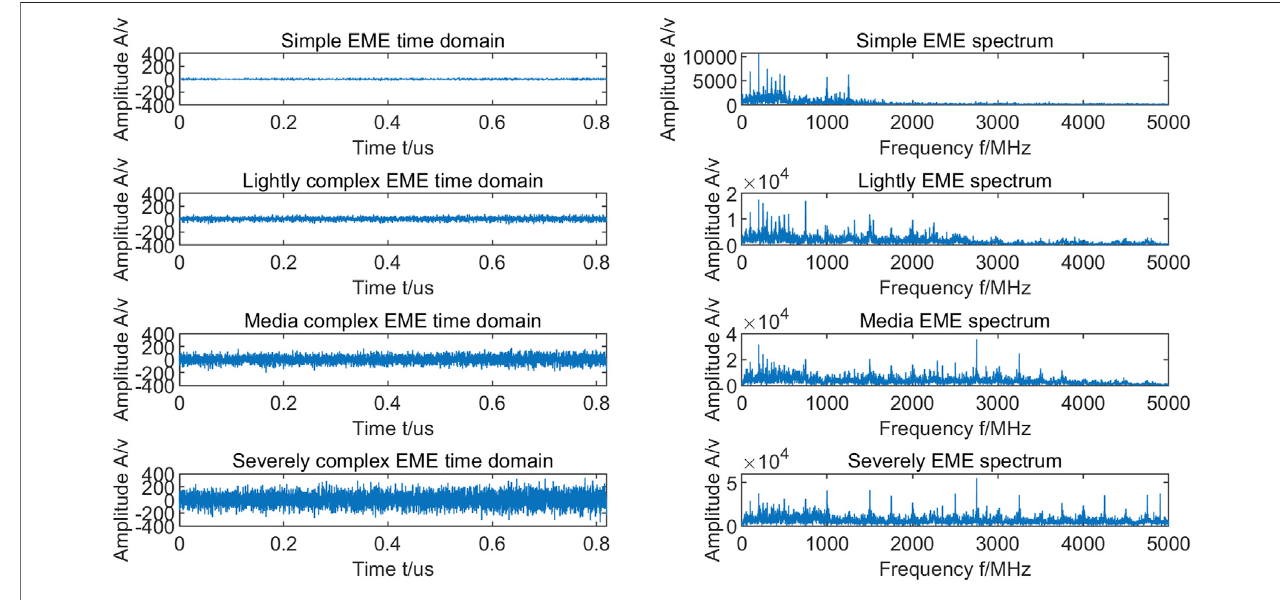
FIGURE 1 | Simulation for EME signal.